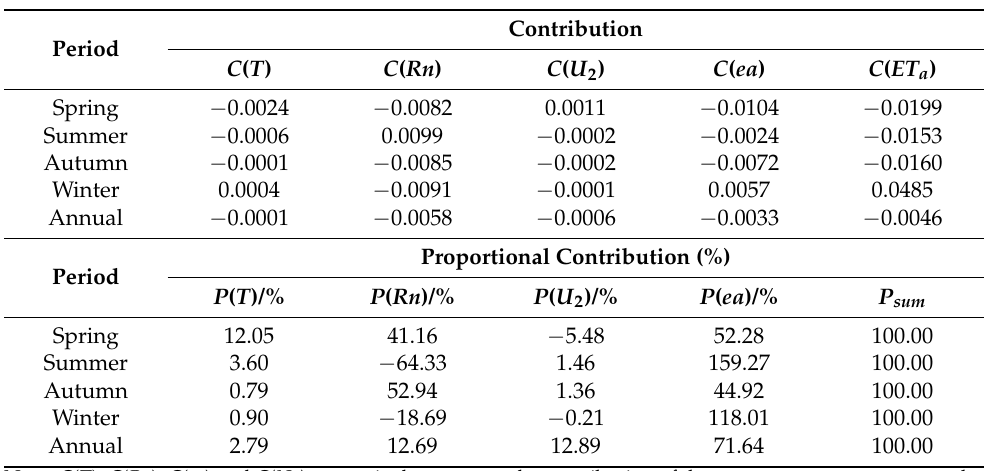
Figure 6. Spatial distribution of the mean annual sensitivity coefficients of the Weihe River Basin. Table 6. Contributions of meteorological variables to the long-term trend in ET a